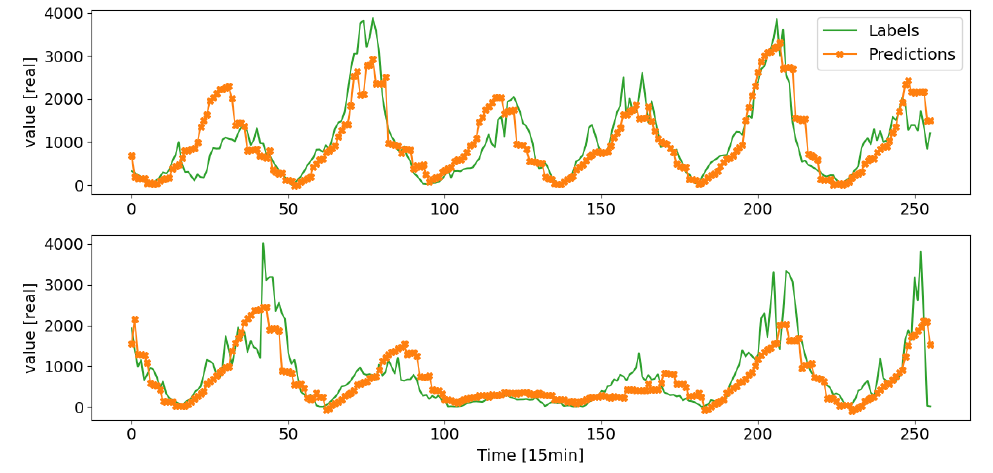
Figure 5. An example of performance of baseline architecture on test data. These data represent the solar irradiance over several consecutive days without taking into account night